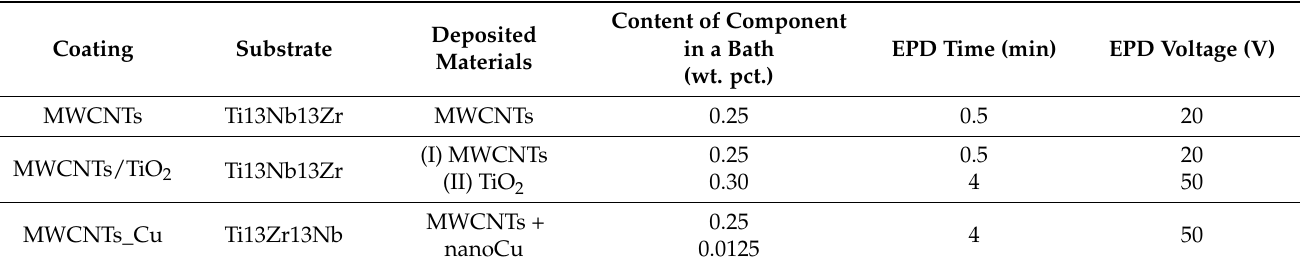
Table 2. Parameters of synthesis of